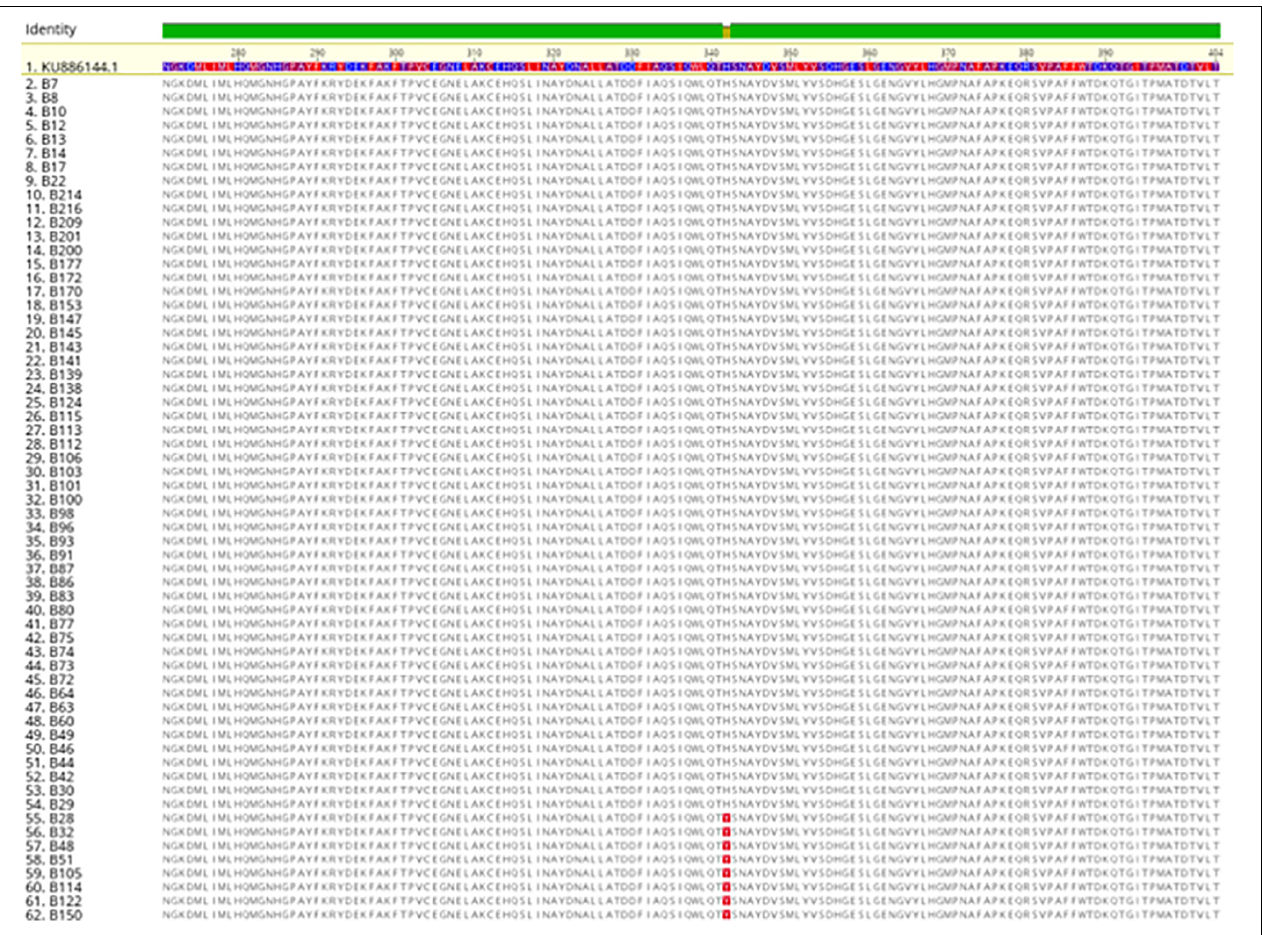
FIGURE 3 | Protein Alignment of mcr-1 positive strains examined in this